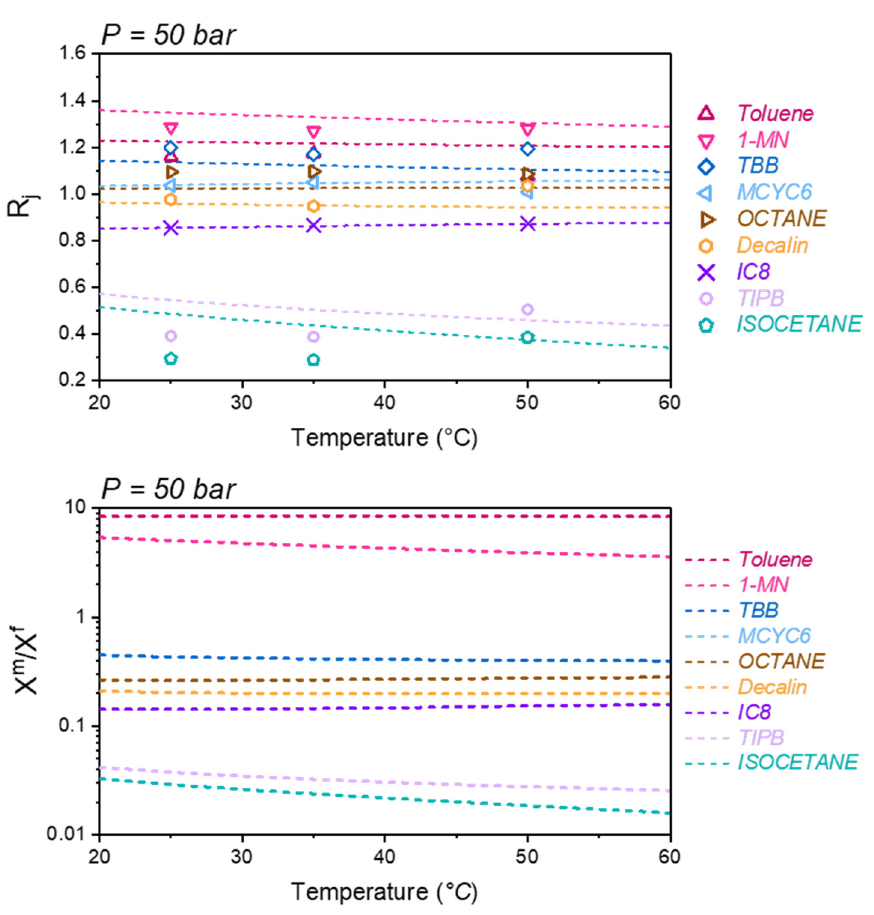
Figure 5. Top: Separation coefficients (Equation (2)) for the SBAD-1 membrane separation of a complex liquid feed composition listed in Table 4, at a fixed feed pressure of 50 bar. Symbols are experimental data [3] and curves are predictions using Equation (6). ( Bottom ): Same as ( top ) except plotting model predictions of the ratio of mole fraction in membrane at the feed interface to the feed.